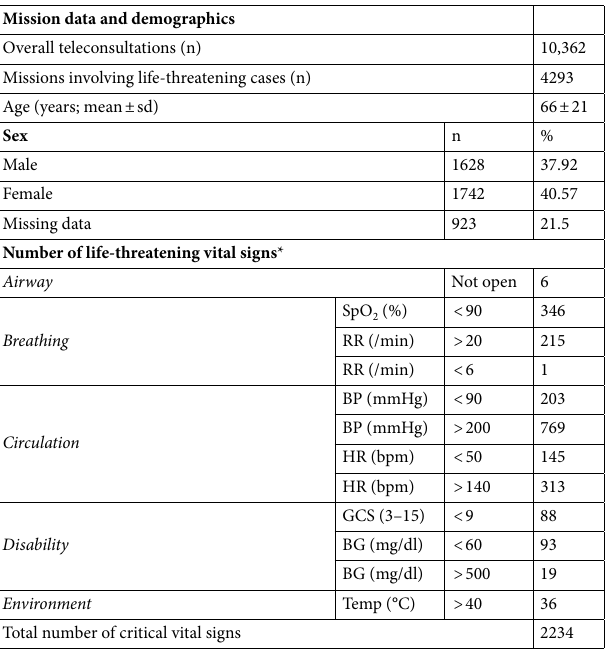
Table 1. Mission data, demographics, and number of life-threatening vital signs. Mission data and demographics (upper table); Breakdown of the numbers of life-threatening vital signs (lower table). Sd